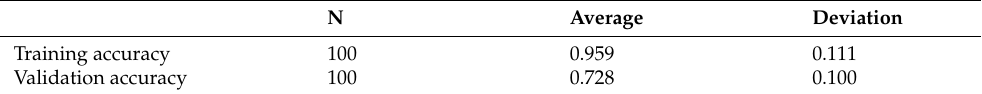
Table 3. Mean and standard deviation of training accuracy and validation accuracy.